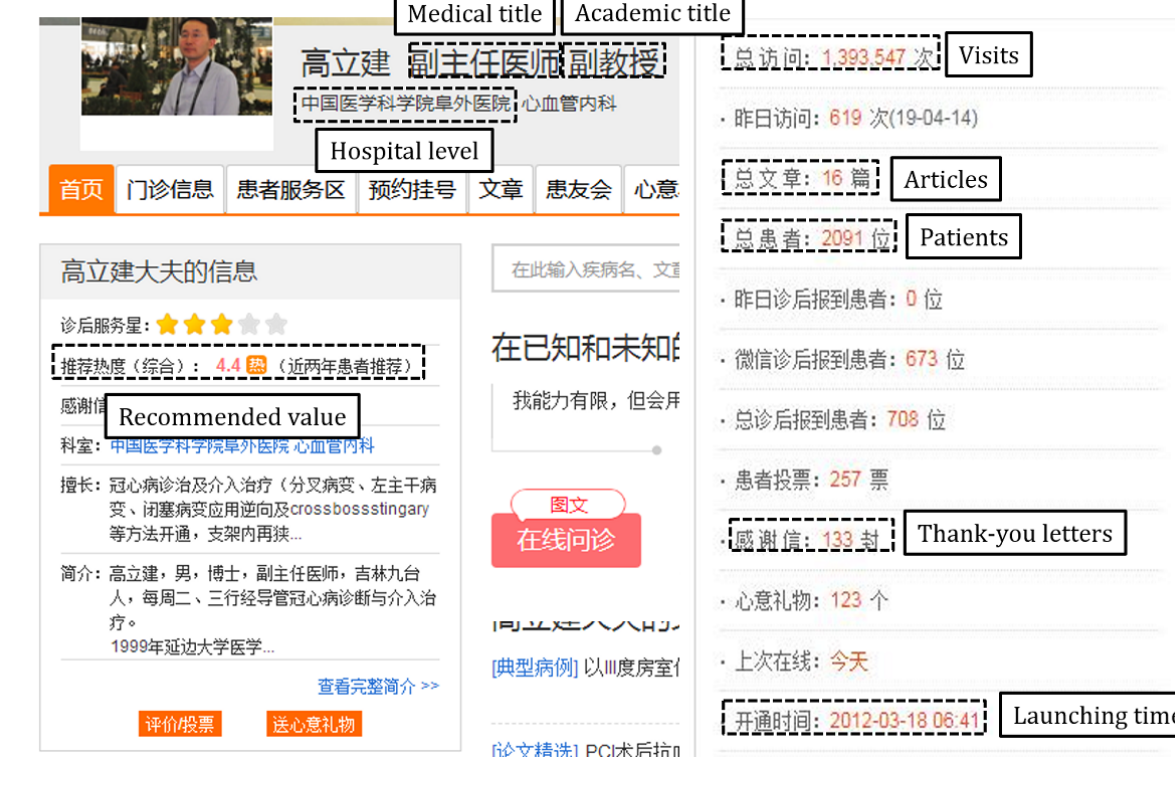
Table 1. Variables